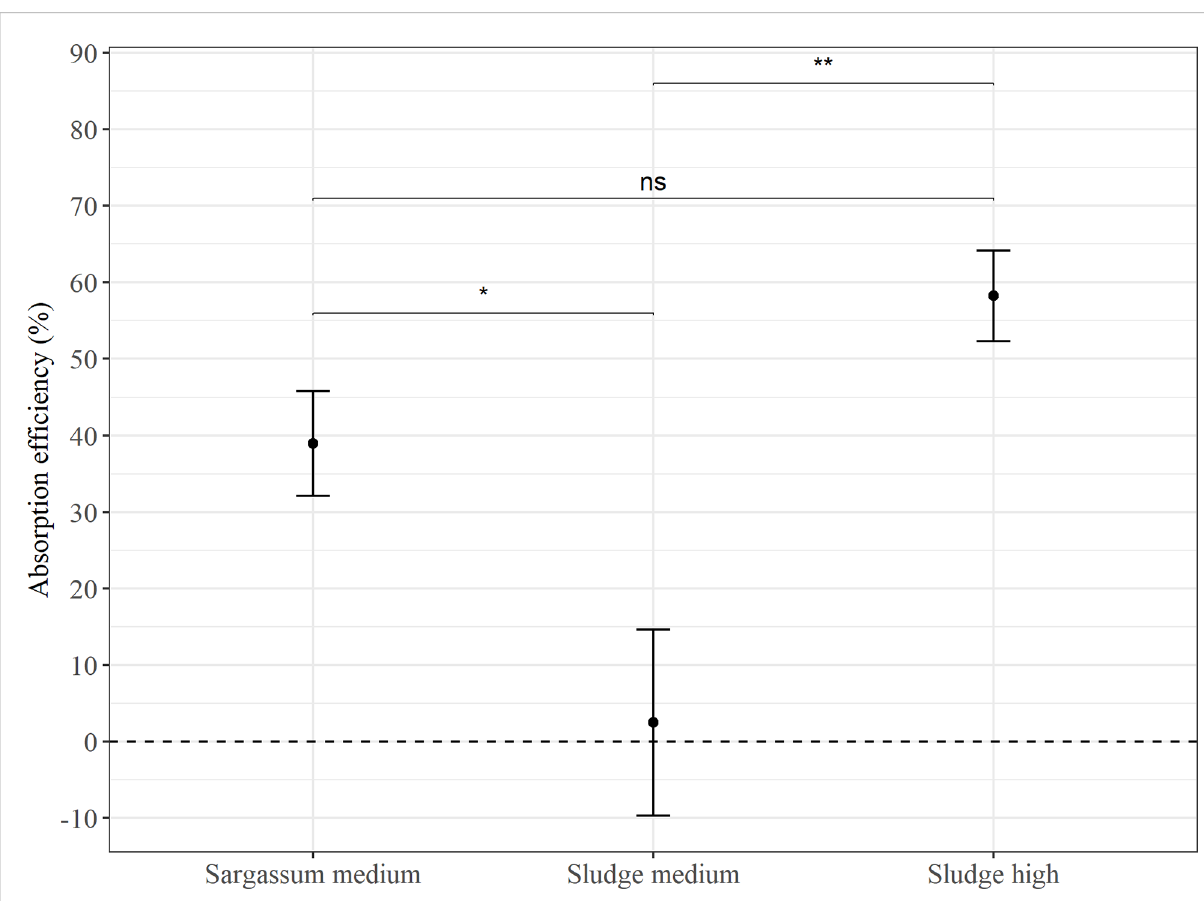
FIGURE 4 Average absorption ef fi ciency (%) in P. tremulus (n=9) given feeds with either Sargassum powder (Sargassum medium: 50% v:v) or aquaculture sludge (Sludge medium: 50% and Sludge high: 75% v:v) over a 10-day period in Experiment 2. Error bars show standard error and signi fi cant differences between feeds are indicated with asterisks (ns, not signi fi cant; *: p ≤ 0.05; **: p ≤